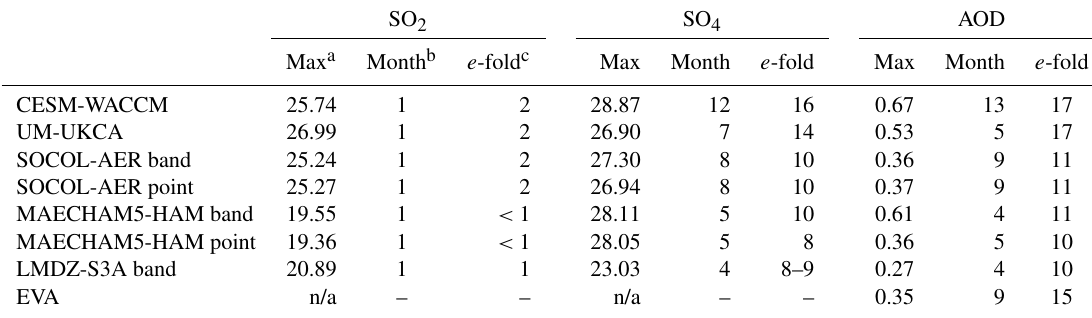
Table 3. Maximum values of global stratospheric burdens of sulfur species (TgS) and AOD: max value, month of injection experiment at which it peaked, e -folding time in months from peak value. n/a stands for not applicable. SO 2